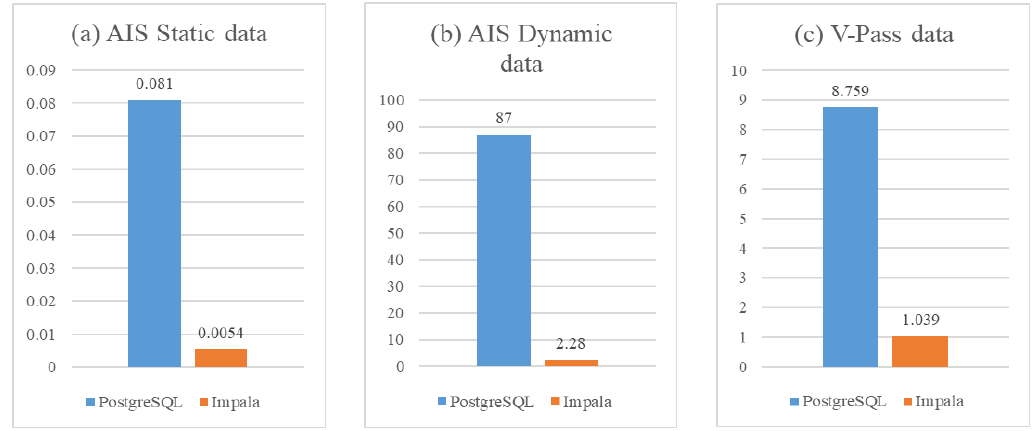
Figure 14. Query Response Time (i.e., second) Comparison Results between PostgreSQL and Im- pala.